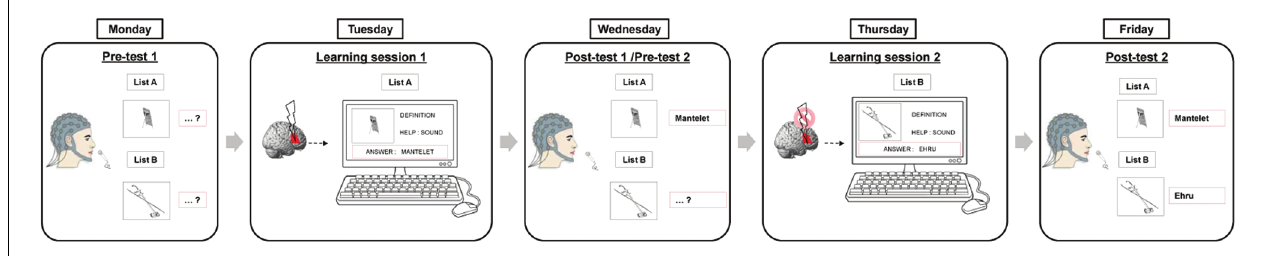
FIGURE 1 | Experimental design. Participants ( n = 16) underwent two learning sessions on Tuesdays and Thursdays. During each session, participants first received active or sham cTBS over the right Broca homolog followed by training of one list on a computer. One day before and after each training session, overt naming skills were tested for the learned and non-learned